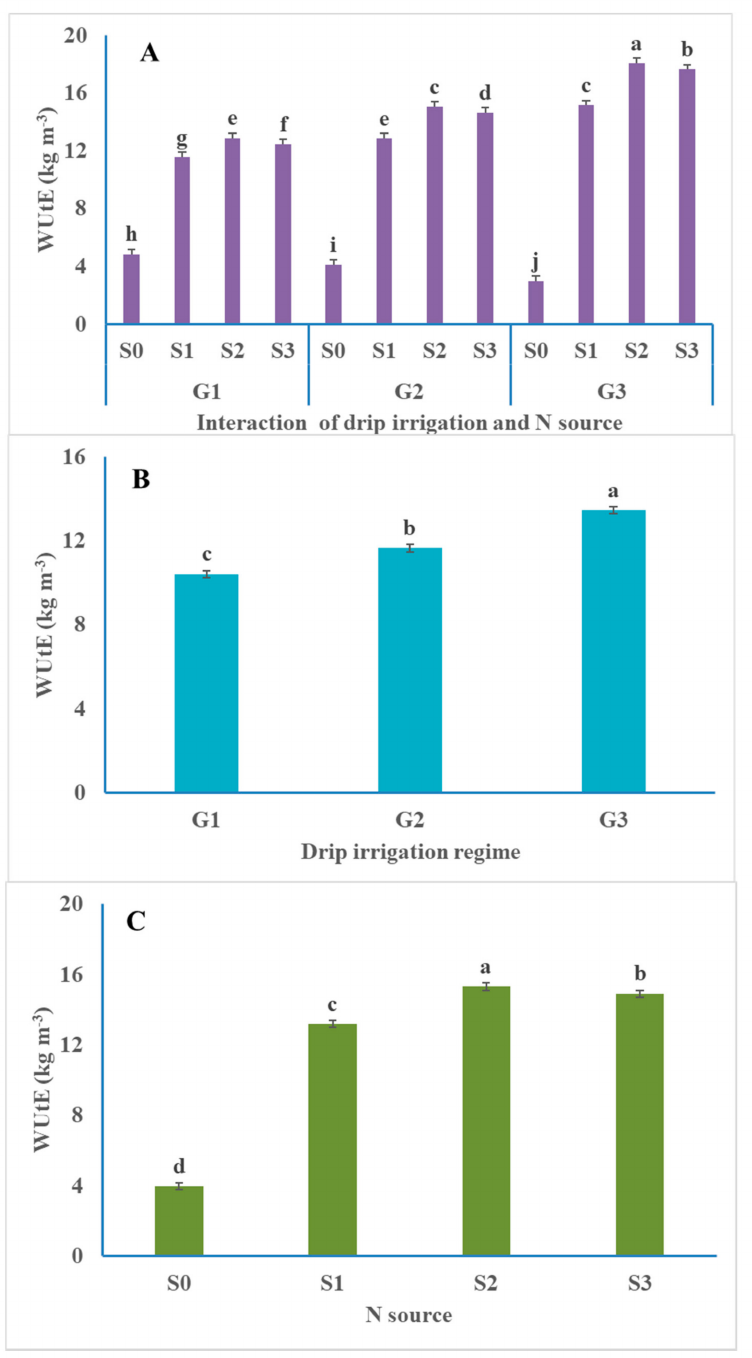
Figure 4. Average e ff ect of drip irrigation regime ( B ), N source ( C ) and their interaction ( A ) on water utilization e ffi ciency (WUtE; kg m − 3 ) of potato. G 1 = 120% ETc irrigation; G 2 = 100% ETc irrigation; G 3 = 80% ETc irrigation; S 0 = Unfertilized (control); S 1 = Urea; S 2 = Ammonium nitrate; S 3 = Ammonium sulfate; values for the same parameter without a common letter are significantly di ff ered ( P >